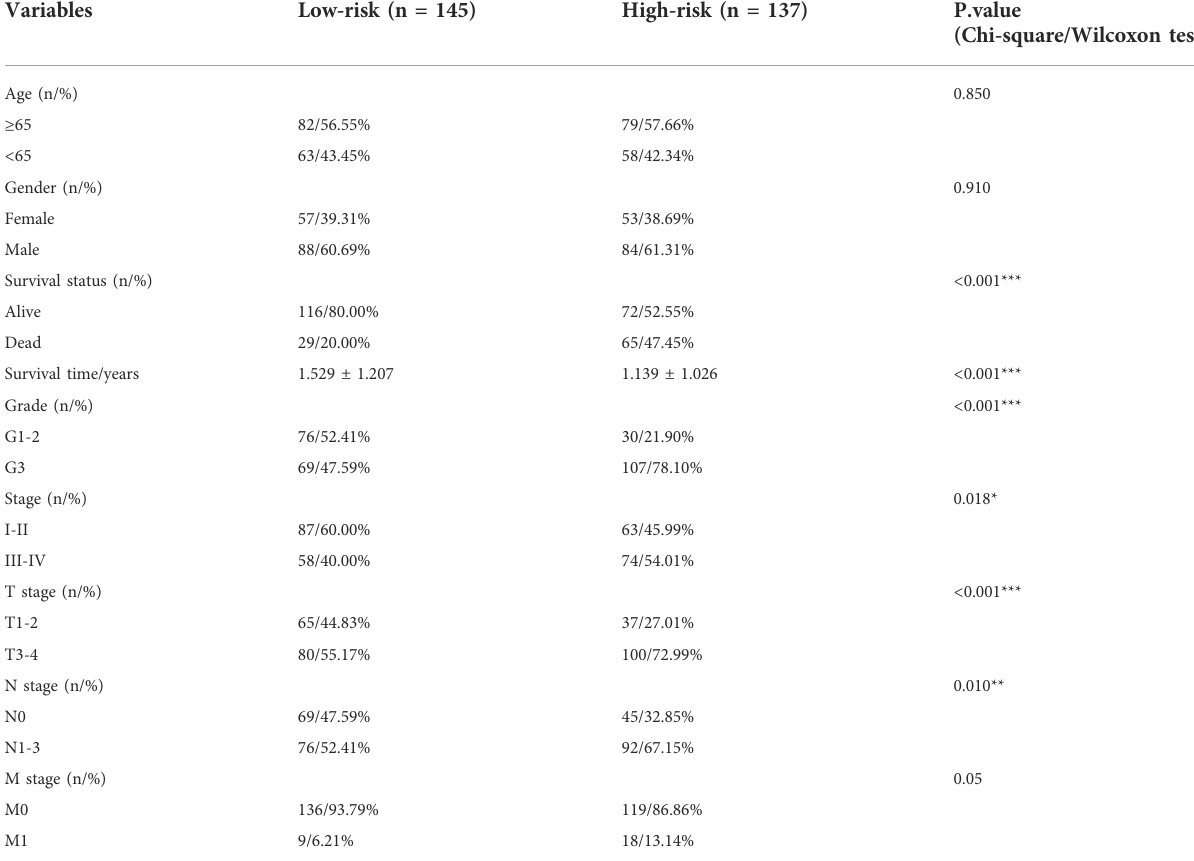
TABLE 1 Comparison of clinical information between RNA modulation-related risk subtypes in STAD